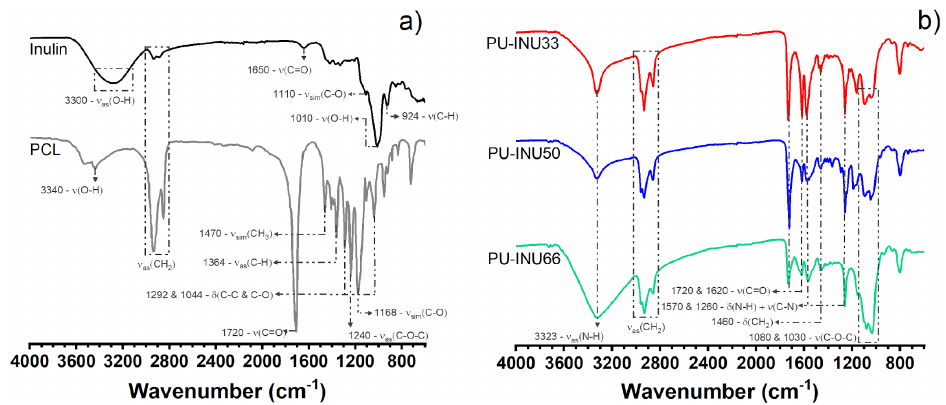
Figure 1. Fourier transform infrared spectroscopy (FT-IR) spectra of ( a ) INU and polycaprolactone diol (PCL-diol) as polyol precursors and ( b ) PU–INU base materials and their adsorption characteristic bands. Nomenclature corresponds to: ν = stretching, δ = bending, and ω = wagging.